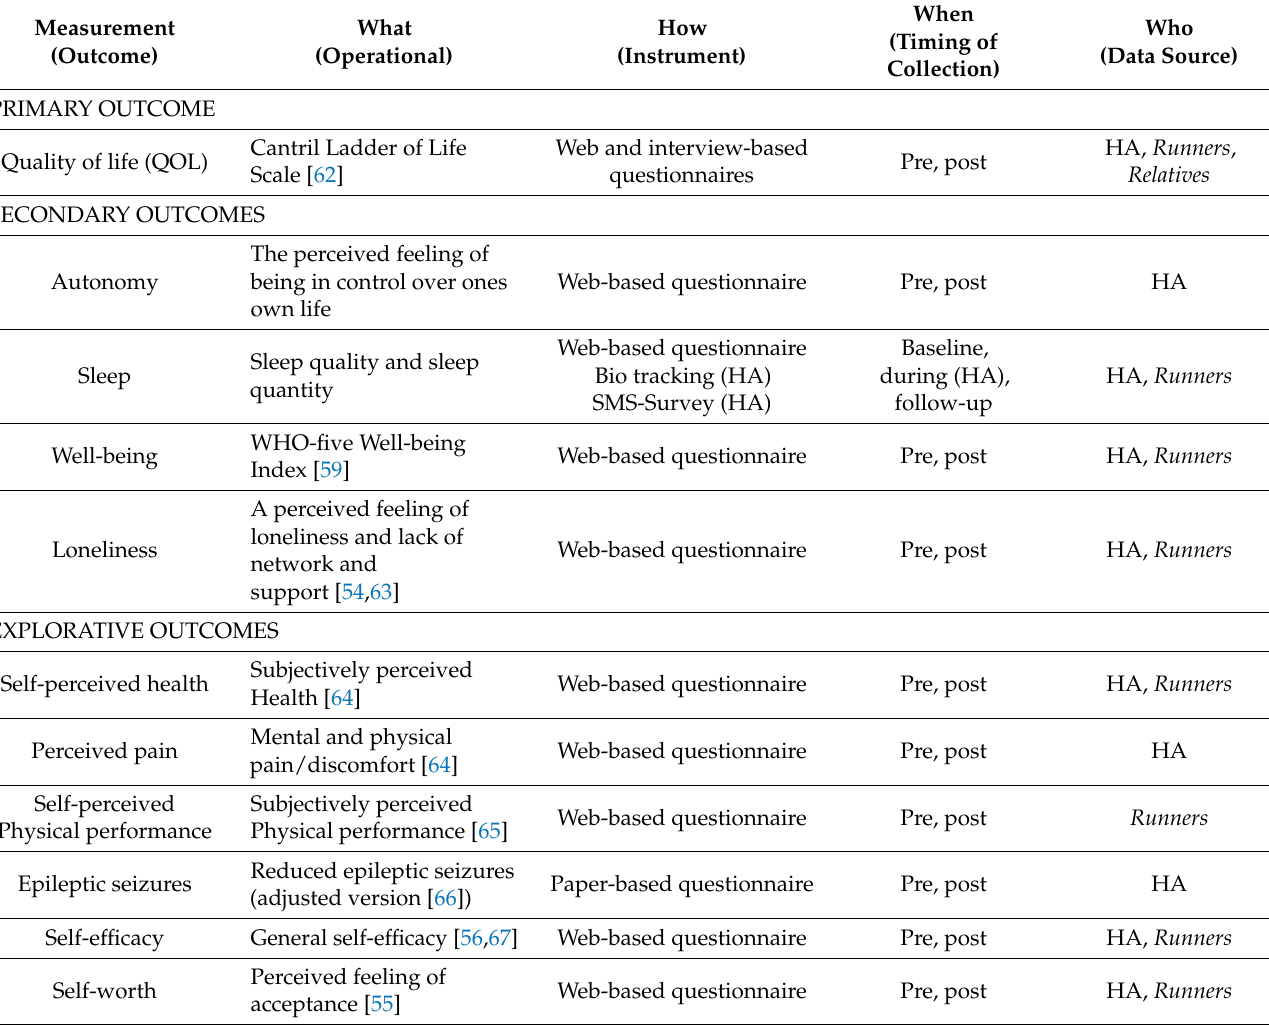
Table 2. Outcomes and measures in the Team Twin